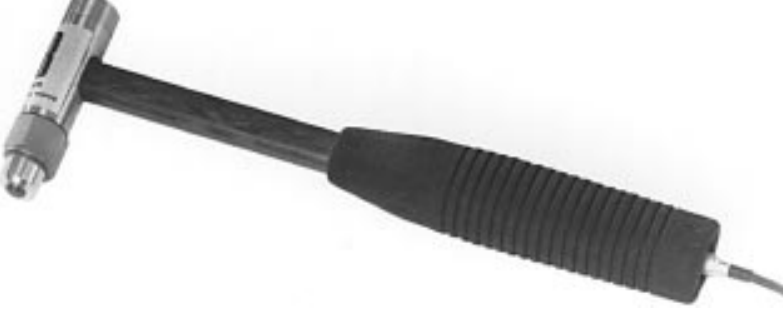
Fig. 4. The first modally tuned impulse hammer (PCB,